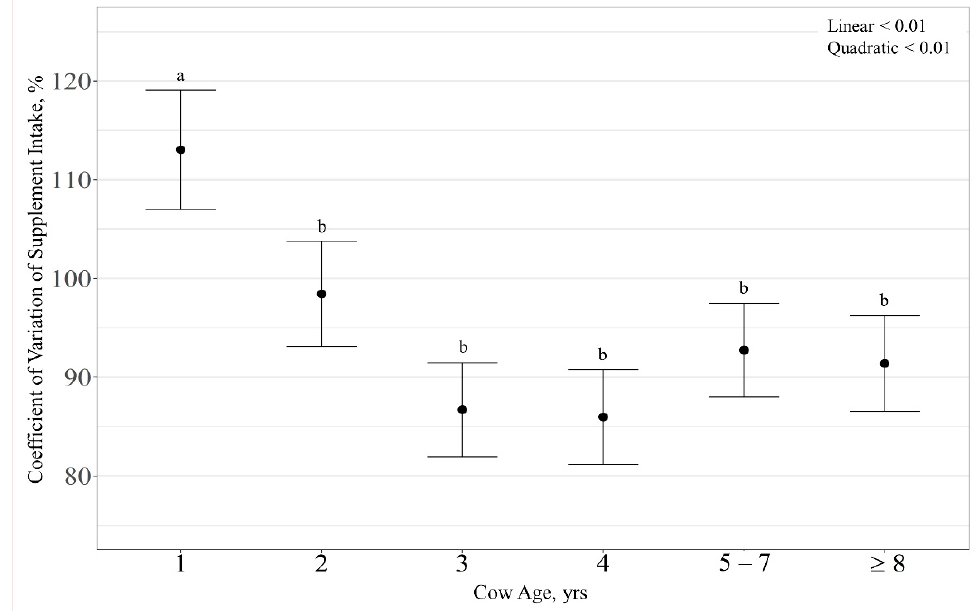
Figure 3. Influence of cow age on coefficient of variation of supplement intake (expressed as % ± SE) by cattle grazing dormant northern mixed-grass prairie in 2018/2019 and 2019/2020 at the Northern Agriculture Research Center’s Thackeray Ranch, Havre, MT, USA. Means lacking common letters (a, b) differ ( p <